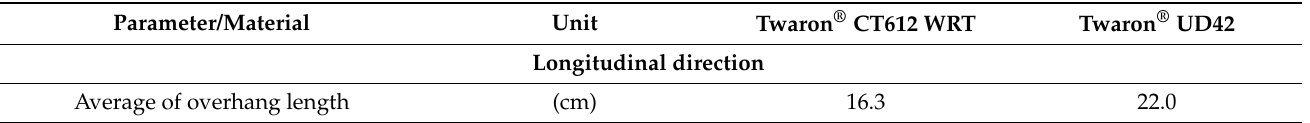
Table 2. Bending stiffness for single Twaron ® layers determined in accordance with the PN-73/P- 04631:1974